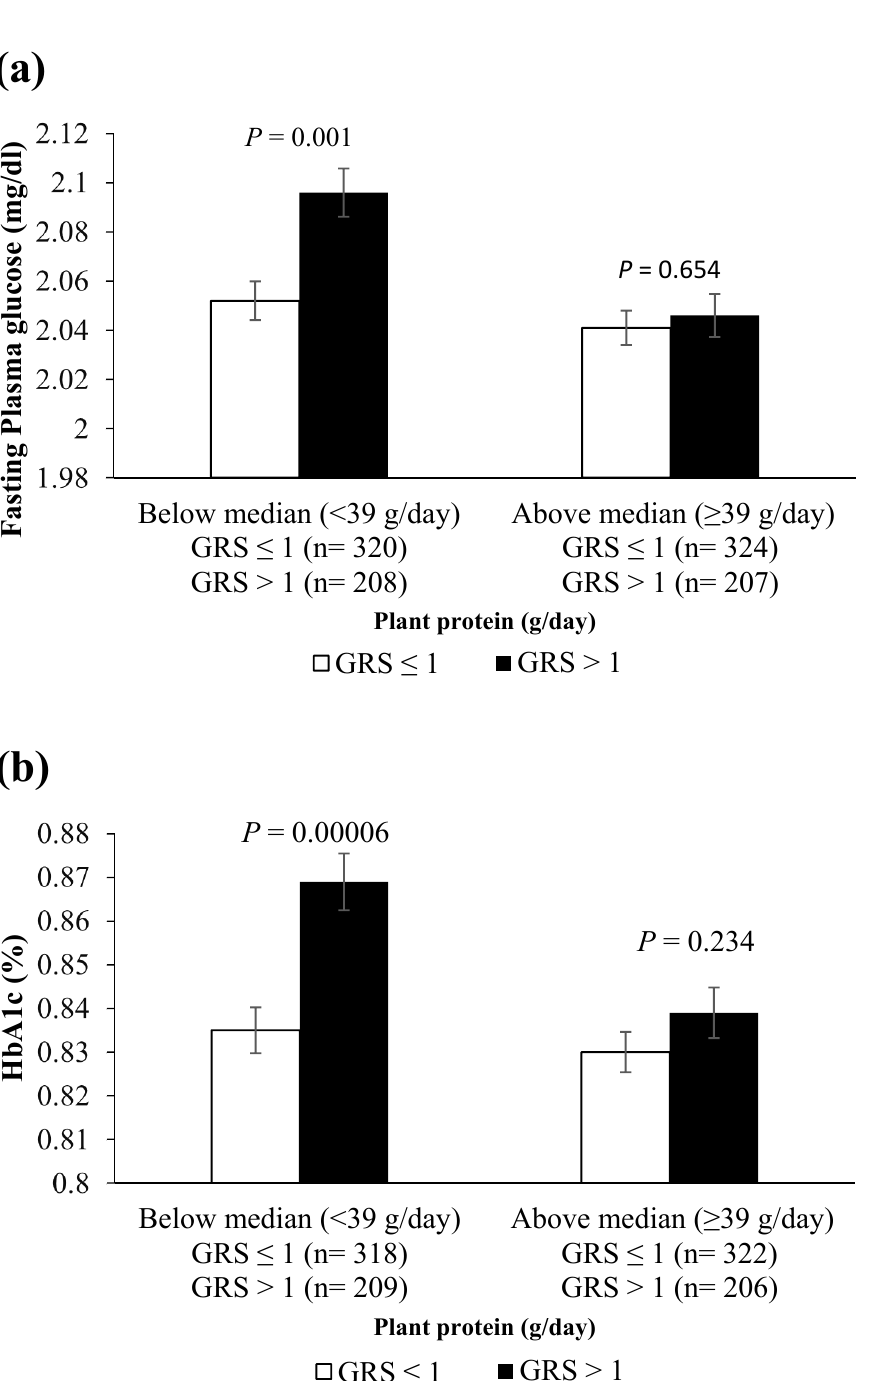
Figure 1. Interaction between 3-SNP GRS and plant protein intake on fasting plasma glucose and glycated haemoglobin. White bars refer to individuals with GRS ≤ 1 risk allele; the black bars refer to individuals with GRS > 1 risk allele. ( a ) Individuals with >1 risk allele had a significantly higher FPG compared to those with ≤ 1 risk allele, among those with lower intake of plant protein (<39 g/day) ( p = 0.001). ( b ) Individuals with >1 risk allele had a significantly higher HbA1c compared to those with ≤ 1 risk allele, among those with lower intake of plant protein (<39 g/day) ( p = 0.00006). p values were adjusted for age, sex, T2D, BMI, anti-diabetic medication, total fat intake (%) and TEI. Abbreviations: GRS, genetic risk score; FPG, fasting plasma glucose; HbA1c, glycated haemoglobin; TEI, total energy